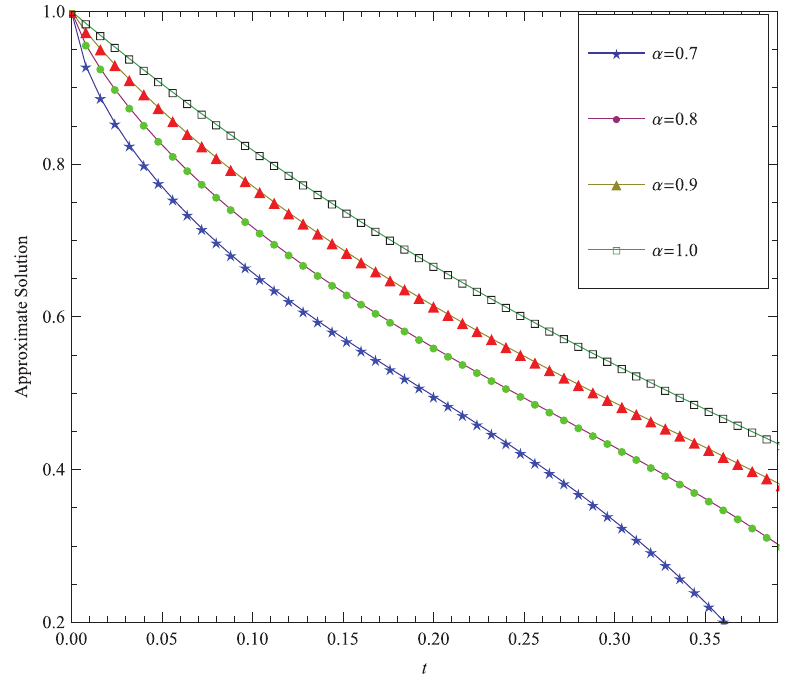
Figure 5. Plot of approximate solution for different values of α : α = 0.7, 0.8, 0.9 and 1.